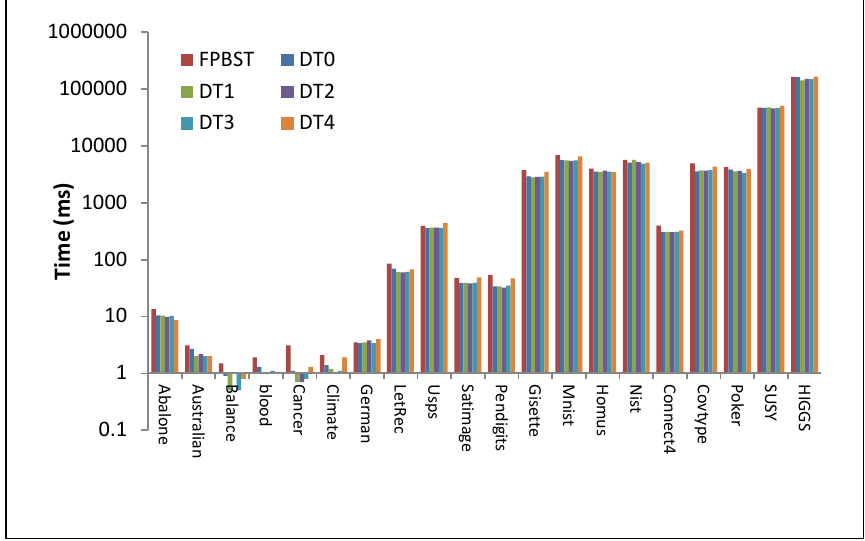
Figure 8. Illustration of data from Table 6 (time (ms) consumed by the FPBST to test the entire test examples compared to that of the proposed methods), the time axis is logarithmic base-10. As can be seen from Table 6 and Figure 8, the consumed time in the testing phase for DT0 – DT3 is less than that of the FPBST, this is due to the smaller size of these threes, and the disuse of the KNN classifier, it is interesting to note that the DT4 speed in the testing phase is almost similar to that of the FPBST, this is due the large and equal size of their trees. It is also interesting to note that there is no significant difference in the time consumed by the proposed DT0 – DT3 in the testing phases, since they are almost the same except for the method of calculating the probability for each class. Table 7. Speed-up results (training and testing phases) of the proposed methods DT0 – DT4 compared to the FPBST. Dataset